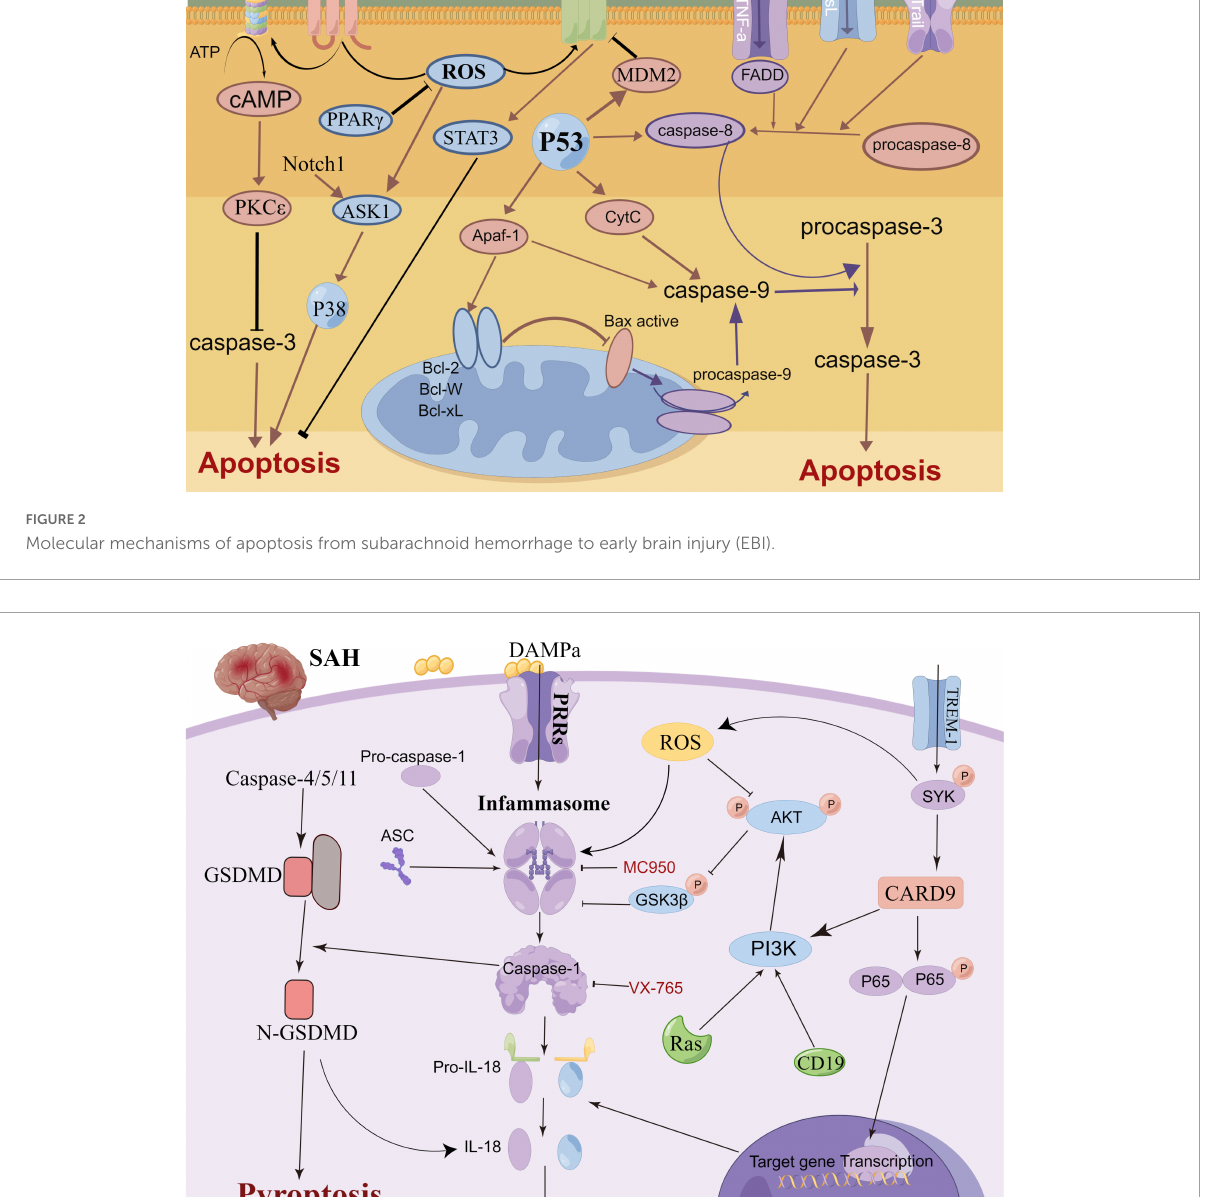
neurons; however, it is activated in large quantities after